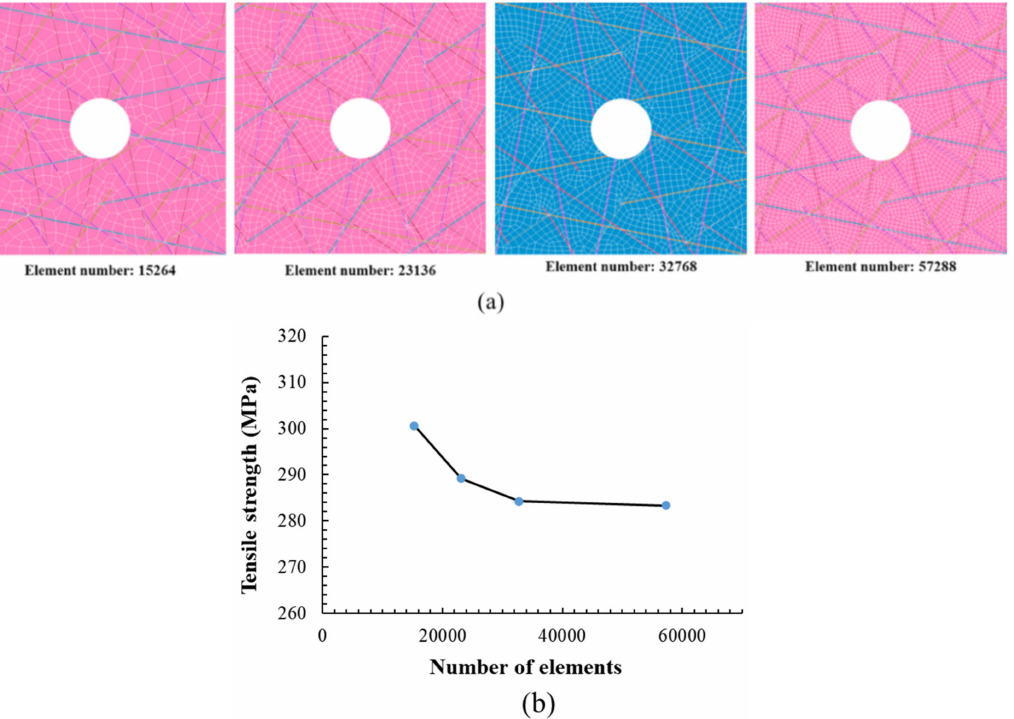
Figure8. E ff ectofthemeshnumberonsimulationaccuracy: ( a )FEMmodelthenotchedUACSlaminates with di ff erent element number, ( b ) e ff ect of the element number on the numerical simulation results.